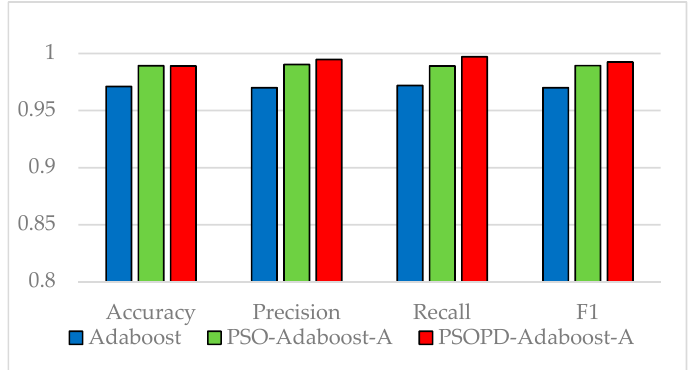
Figure 12. Performance Comparison of the AdaBoost, PSO-AdaBoost-A, and PSOPD-AdaBoost-A on KC1 Dataset.